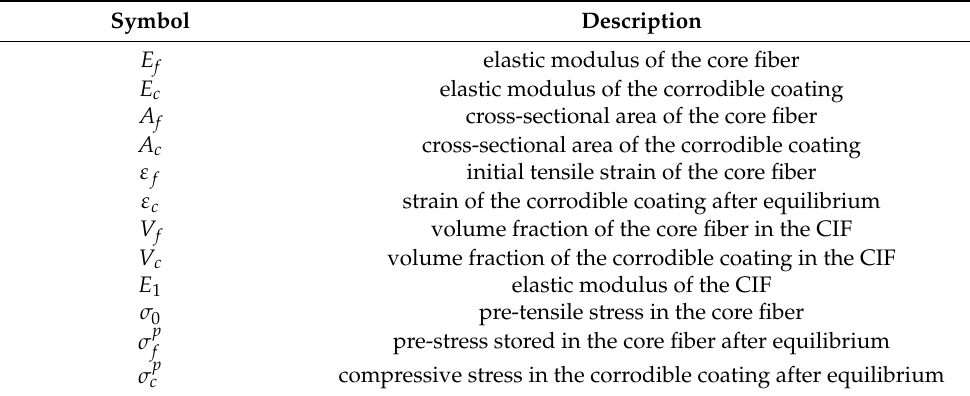
Table A1. Symbols in formula deduction for the corrosion-induced intelligent fiber (CIF).